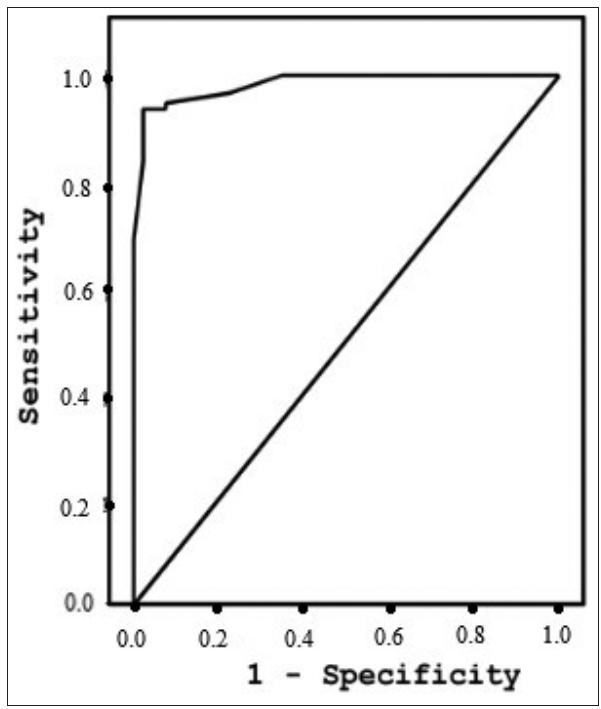
Figure-4: Area under the receiver operating characteristic curve for diagnostics of Fasciola gigantica versus healthy cattle (area under curve=0.98; p<0.0001).